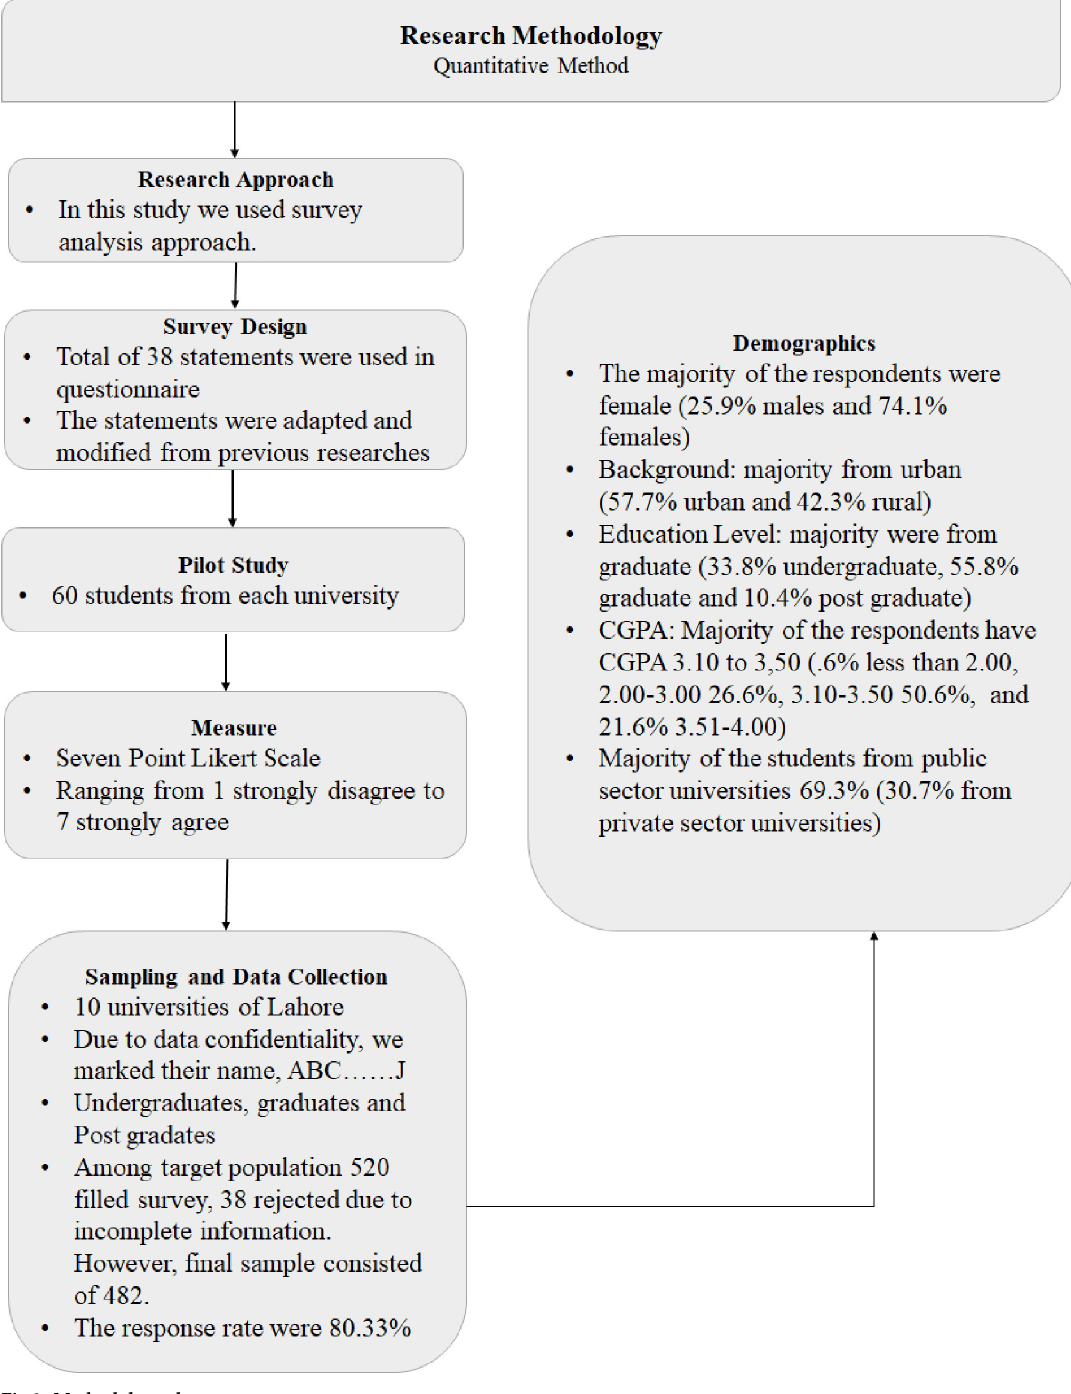
Fig 2. Methodology